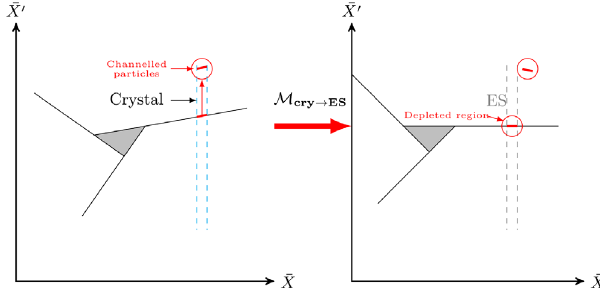
FIG. 6. Schematic representation of third integer resonant slow extraction shadowing of ES with thin